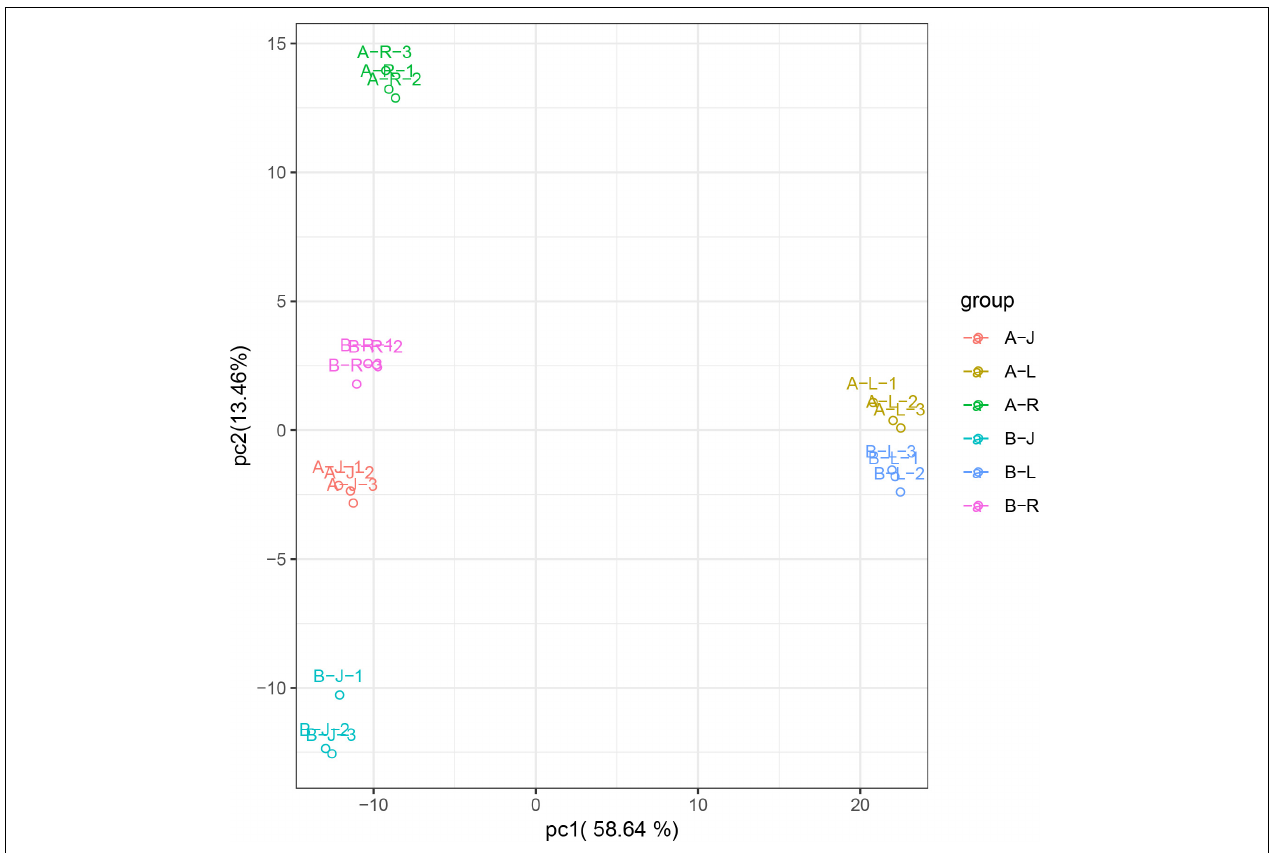
FIGURE 7 | Metabolics analysis using a principal component